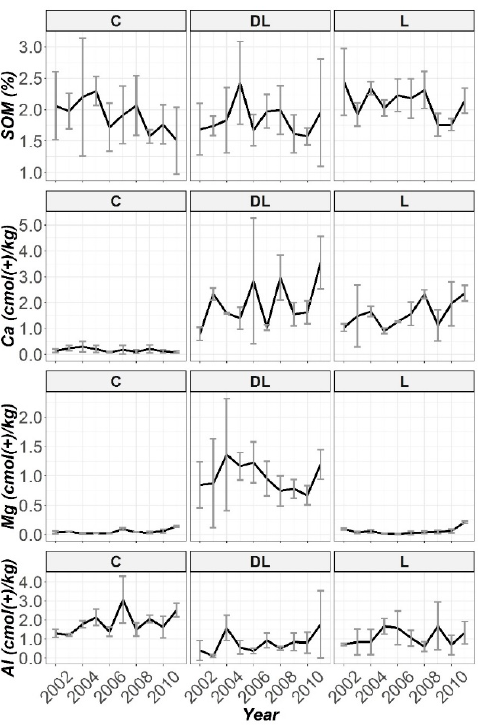
Figure 3. Temporal evolution of SOM, Ca, Mg and Al in the Ap2 horizon throughout the ten years of soil monitoring (2002–2011).